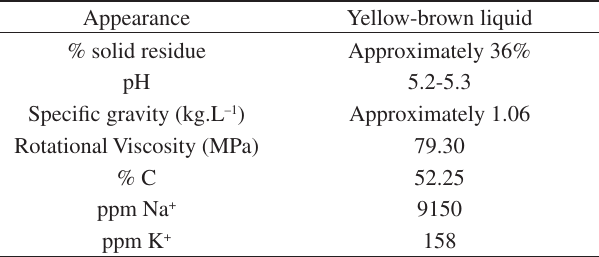
Table 3. Physical and chemical characteristics of the polycarboxylate admixture.